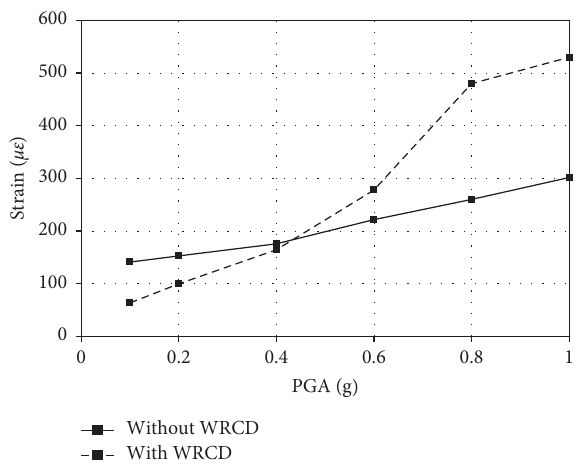
Figure 19: Maximum strain response at 4# sliding pier bottom.